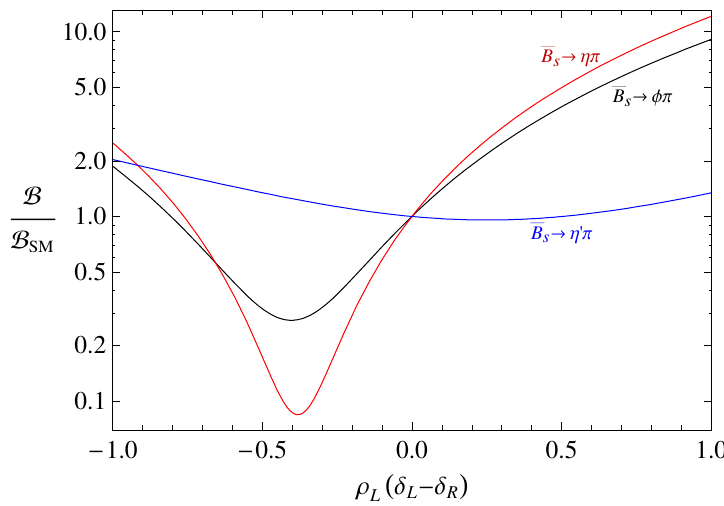
Figure 4 . The calculated branching fractions of (cid:22) B s ! (cid:17)(cid:25) 0 (red curve), (cid:22) B s ! (cid:17) 0 (cid:25) 0 (blue curve), and (cid:22) B s ! (cid:30)(cid:25) 0 (black curve), normalized by their respective SM values listed in table 2 under SCET Solution 2, versus the product (cid:26)